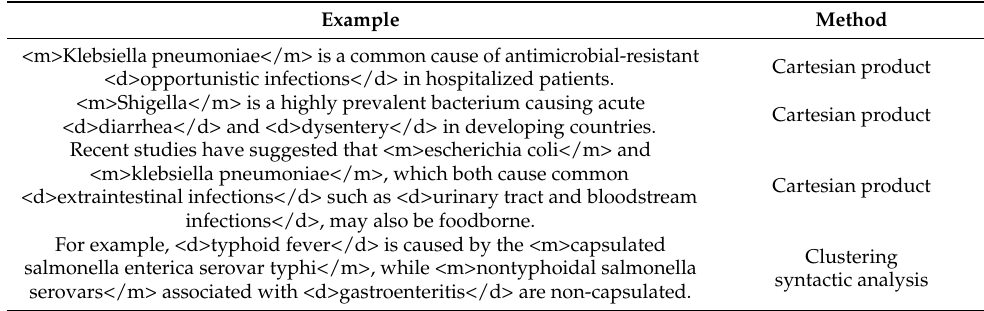
Table 3. Example of entity relationship